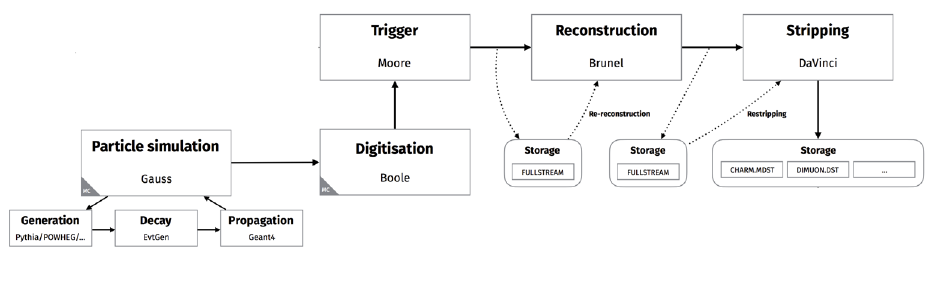
Figure 2. Logical workflow of Monte Carlo simulation in Run